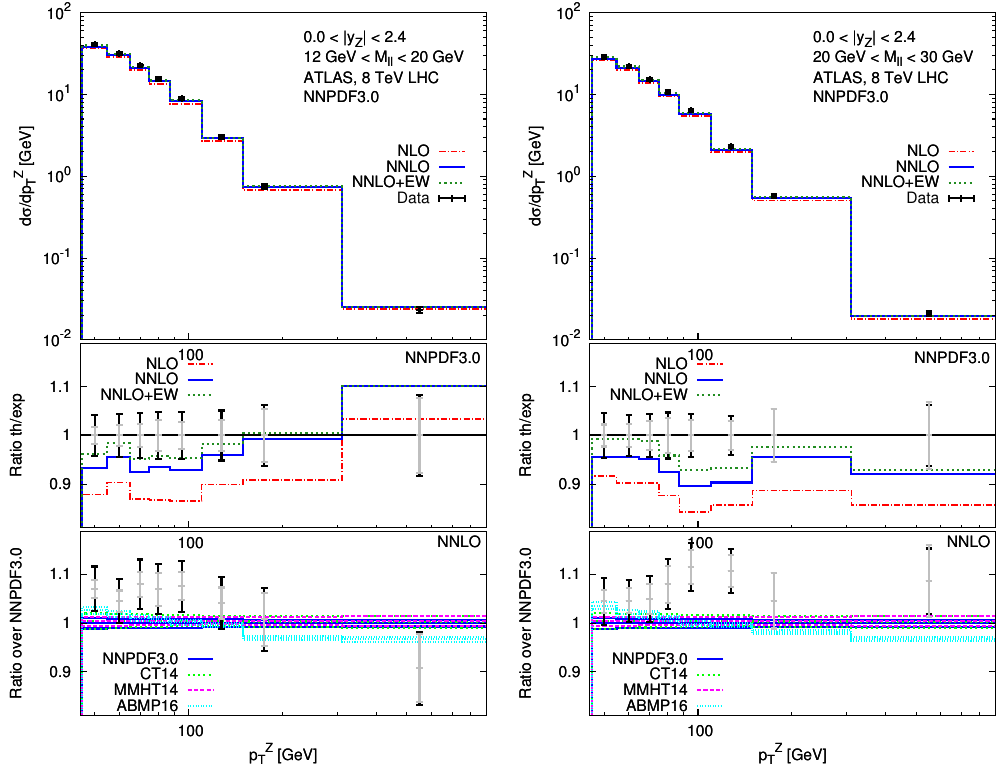
Figure 2 . Same as (cid:12)gure 1 for the ATLAS 8 TeV data divided into invariant mass bins [15]. The two lowest invariant mass bins are displayed.